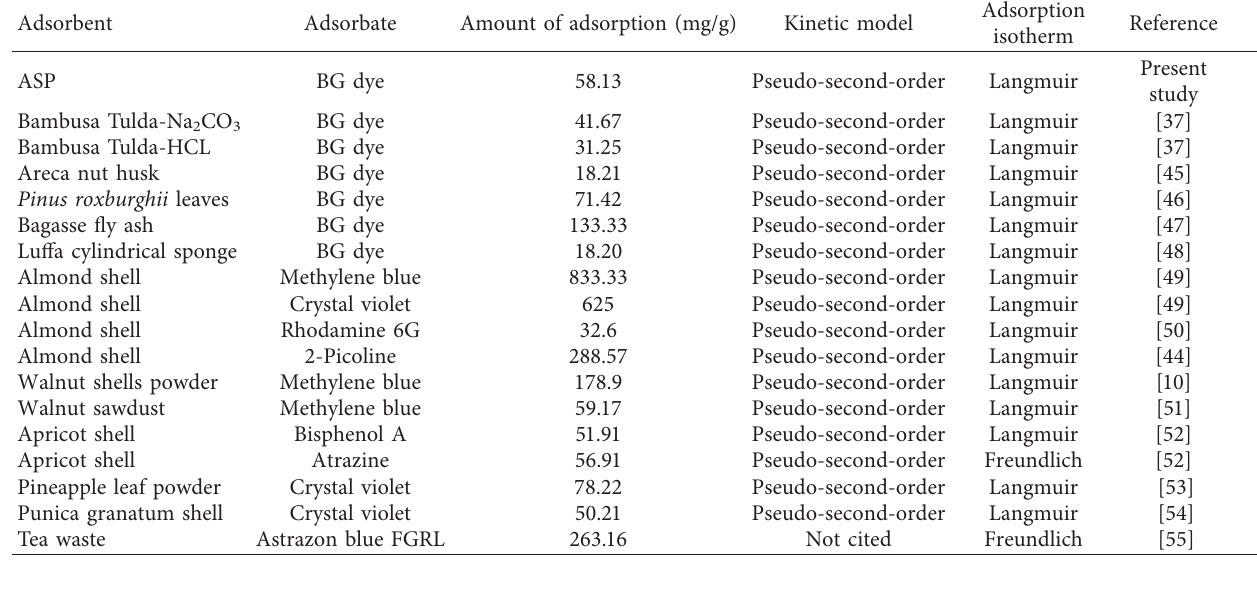
Table 5: Example of data from studies of different adsorbents used for removal of different dyes.